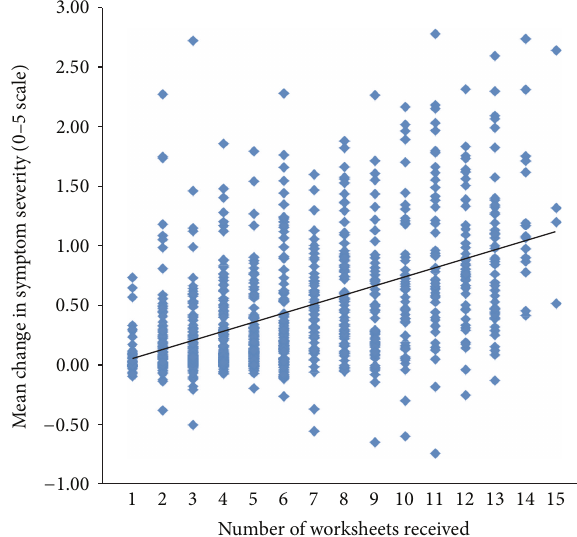
Figure 2: Mean change in symptom severity, as determined by all answered questions on a 0–5 scale from the initial to the final assessment as a function of the number of worksheets received, which served as a reflection of parental engagement with the therapy ( R 2 = 0.26).